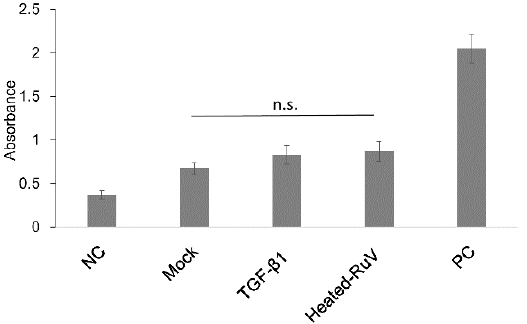
Figure 3. TGF- β 1-induced EMT-like process does not enhance apoptosis in infected cells. ELISA detection of single-stranded DNA present in apoptotic cells at day 5 post-infection. A549 cells were seeded at a density of 10 4 cells/well onto a 96-well flat-bottom plate, as specified by the manufacturer. A549 cells not incubated with RuV and TGF- β 1-treated cells incubated with heat-inactivated RuV were used as negative controls. Single-stranded DNA provided in the ELISA kit was used as a positive control. The results are expressed as the mean of at least three replicates in each group, and the graph is representative of two independent experiments. NC, negative control; mock, cells cultured in DMEM/0.1% BSA without TGF- β 1; TGF- β 1, cells cultured in the presence of TGF- β 1 10 ng/mL; heated-RuV, heat-inactivated RuV; PC, positive control; n.s., non-significant.